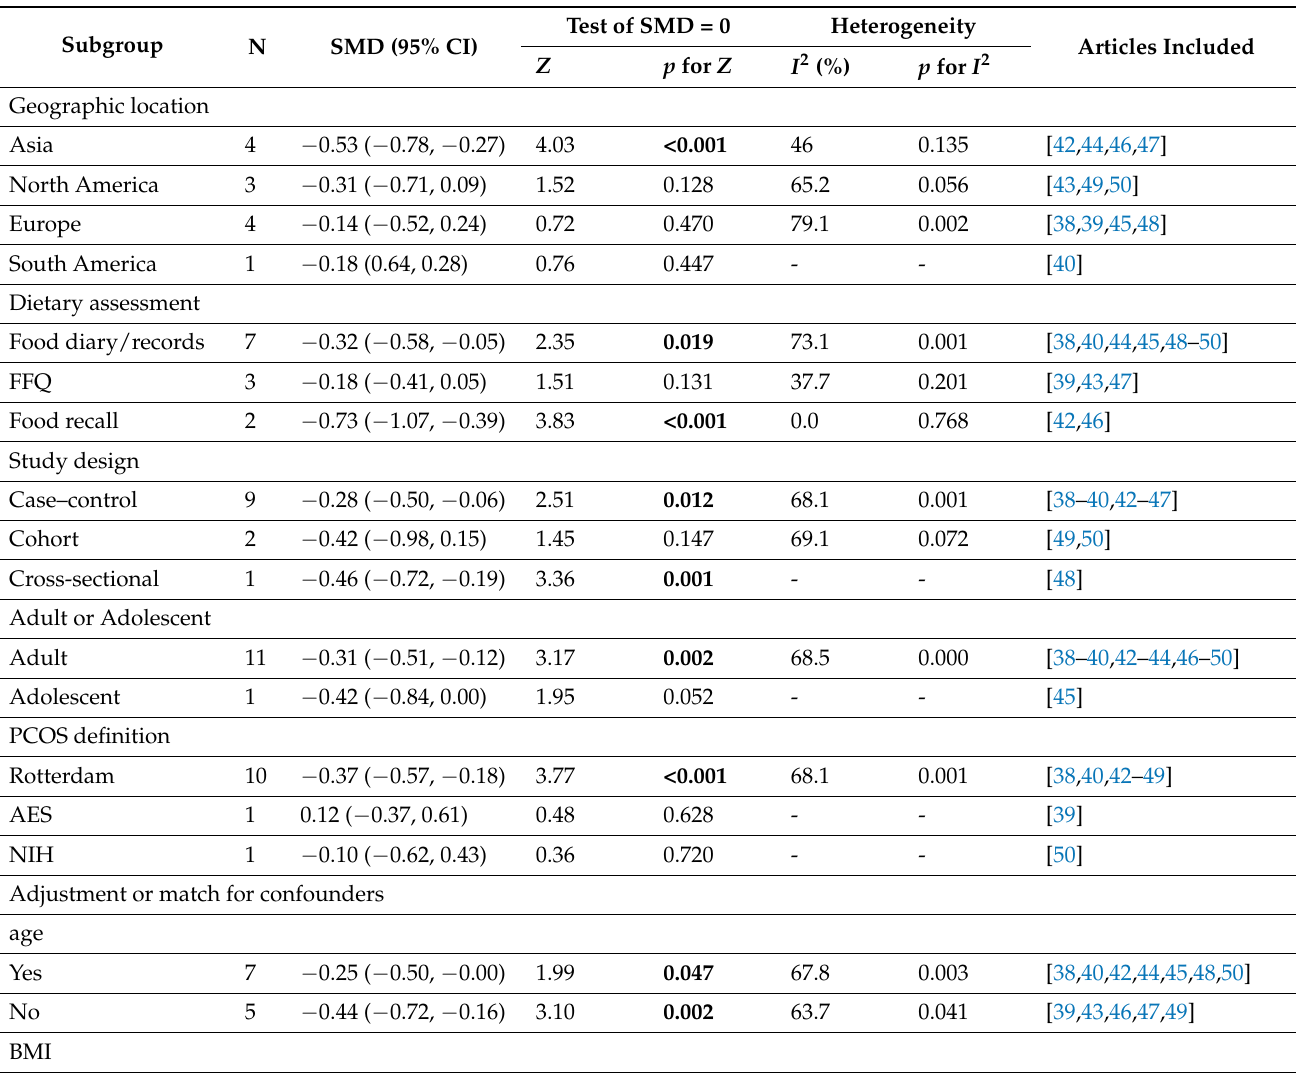
Table 2. Subgroup analysis of dietary fiber intake and